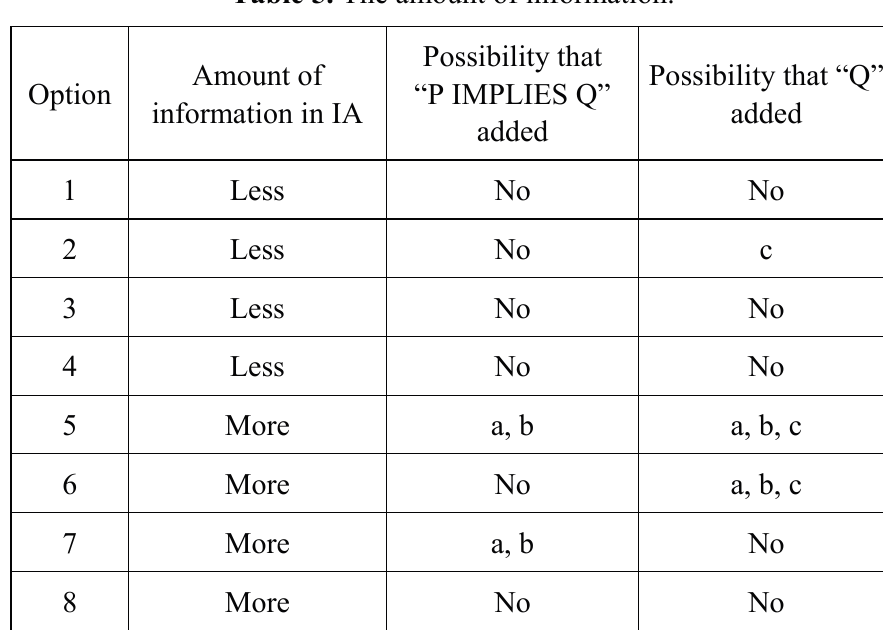
Table 5. The amount of